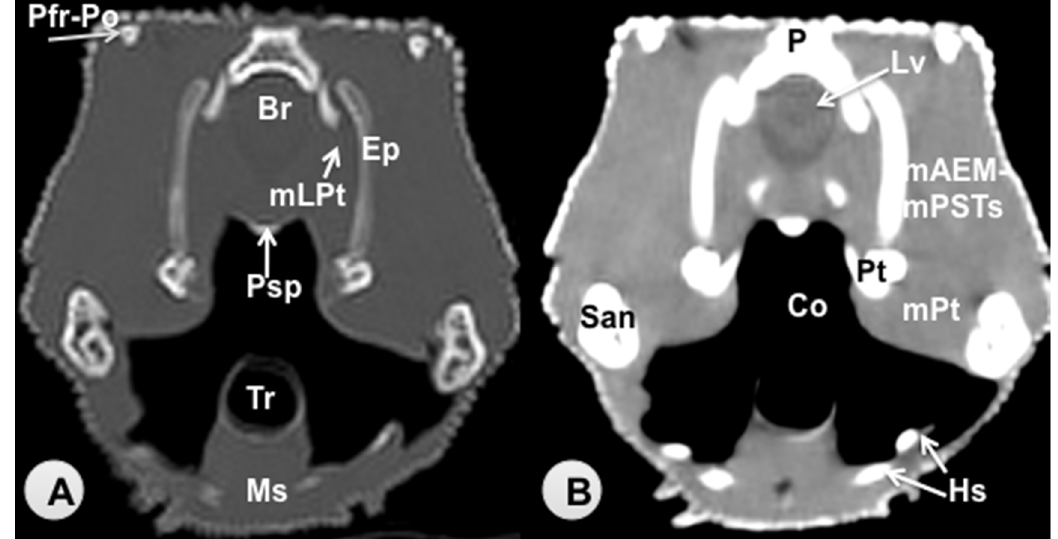
Figure 5. Transverse CT image of the head of Varanus komodoensis at the level of the postorbital + postfrontal bone corre- sponding to line V. ( A ) CT bone window. ( B ) CT soft tissue window. These images are displayed so that the right side of the head is to the viewer’s left and the dorsal view is at the top. P: Parietal bone. Lv: Lateral ventricle. Br: Brain. Ep: Epipterygoid bone. Pt: Pterygoid bone. Psp: Parabasisphenoid bone. Pfr-Po: postfrontal + postorbital bone. San: Surangu- lar bone. Co: Cavum oris. Tr: Trachea. Hs: Hyobranchial skeleton. Ms: Musculus intermandibularis + Musculus geniohy- oideus + Musculus hyoglossus. mAEM-mPSTs: Musculus adductor mandibulae externus + Musculus pseudotemporalis superficialis. mLPt: Musculus levator pterygoideus. mPt: Musculus pterygoideus.